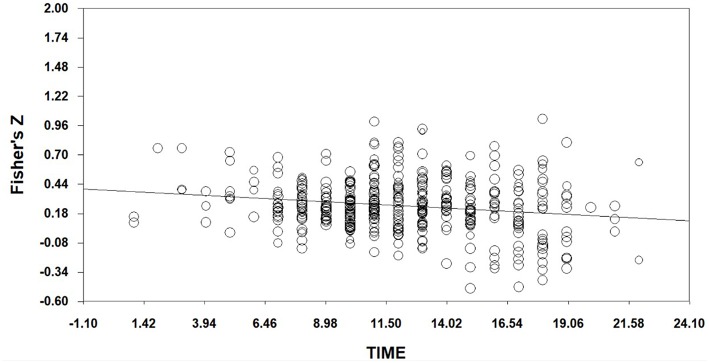
Regression of Time on Fisher's Z (EI).